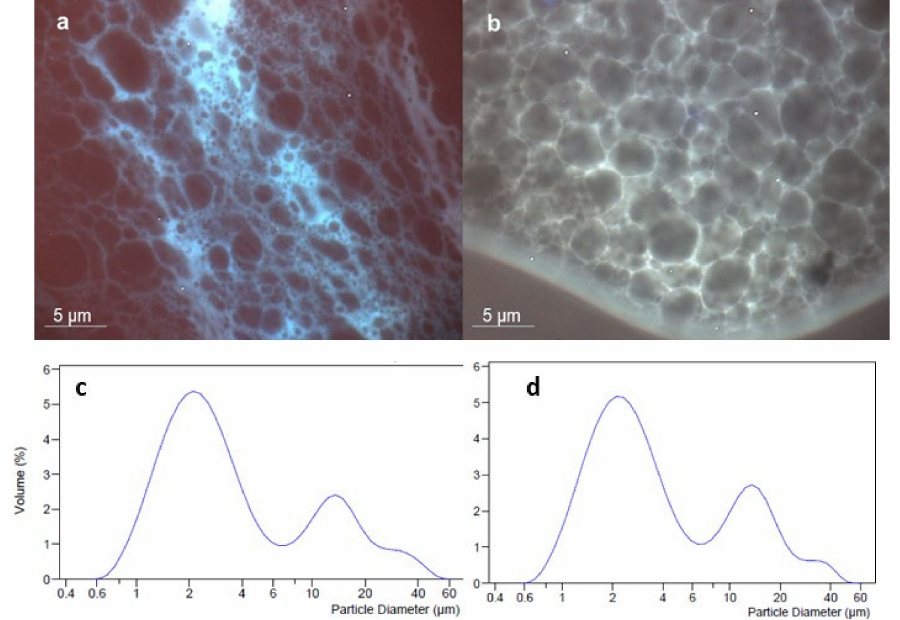
Figure 3. Emulsion system morphology with optical microscopy in fluorescence mode (DAPI filter and darkfield) of blank ( a ) and CSE-loaded ( b ) emulsions and dimensional distribution of oil droplets within the aqueous phase of Blank ( c ) and CSE-loaded ( d )